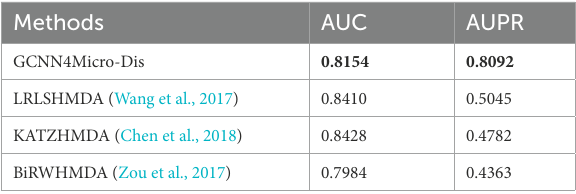
TABLE 3 Comparison of AUC and AUPR for different microbe-disease association predictions methods. Methods